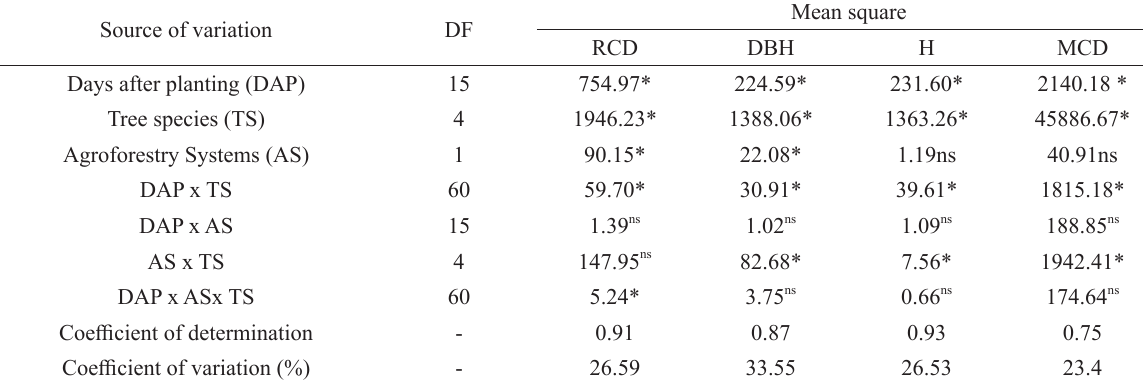
Analysis of variance of root collar diameter (RCD), diameter at breast height (DBH), plant height (H) and mean crown diameter (MCD) of five tree species evaluated in 16 periods after planting in two agroforestry systems, in the city of Frederico Westphalen –